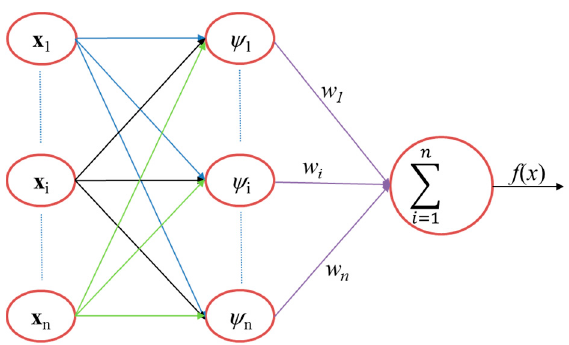
Figure 8. Radial basis function network.